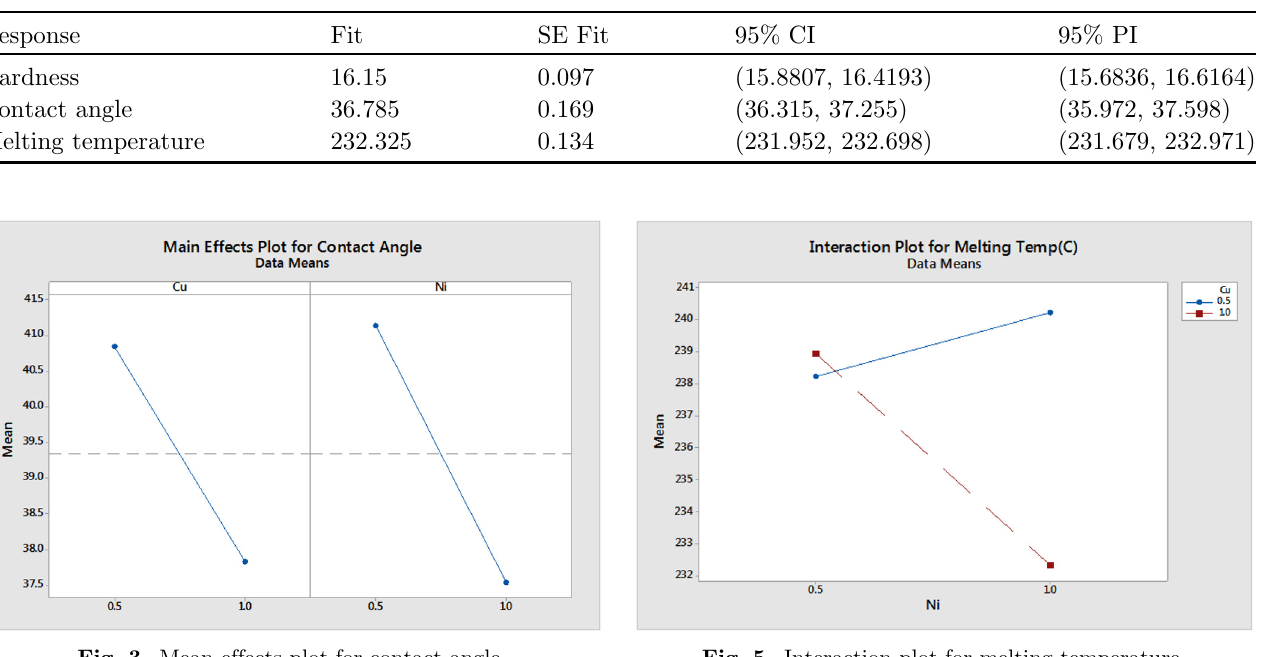
Fig. 3. Mean effects plot for contact angle.